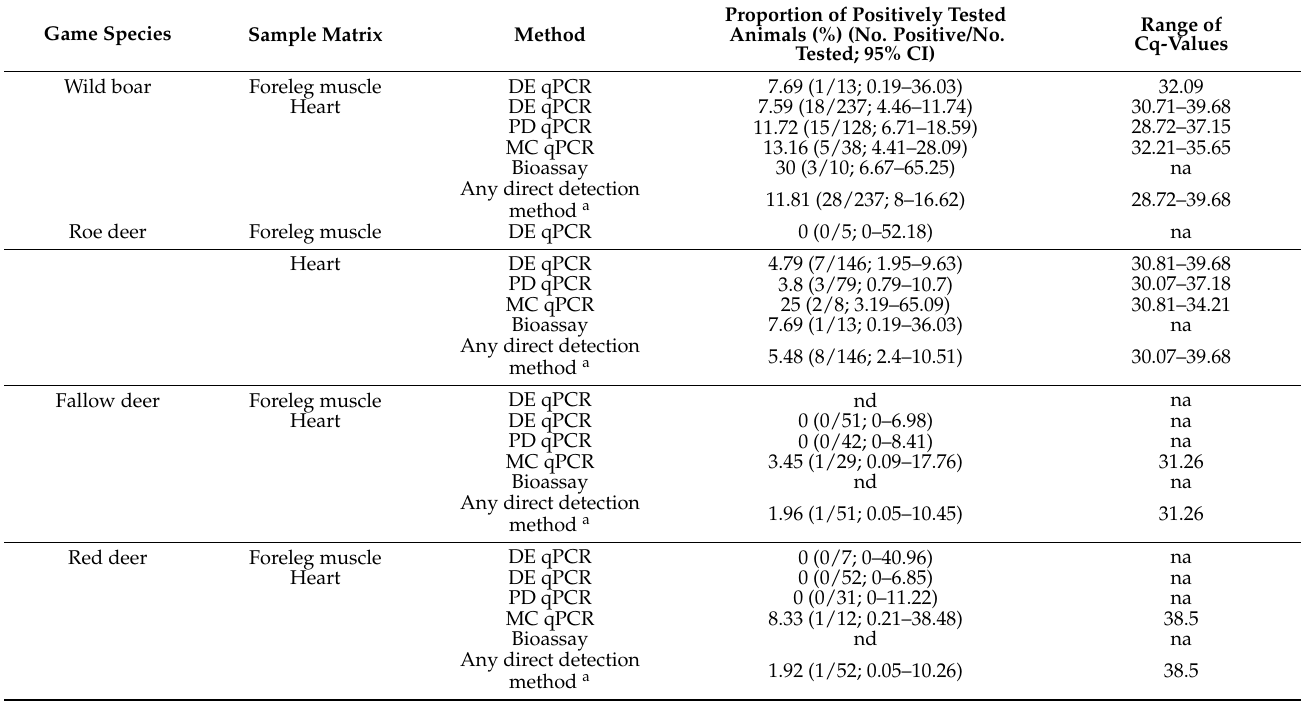
Table 1. Direct detection of Toxoplasma gondii in wild boar and deer.